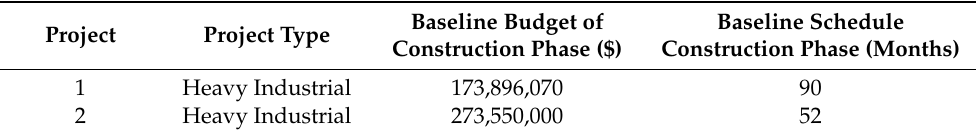
Table 9. General Information of the Case Study Projects.